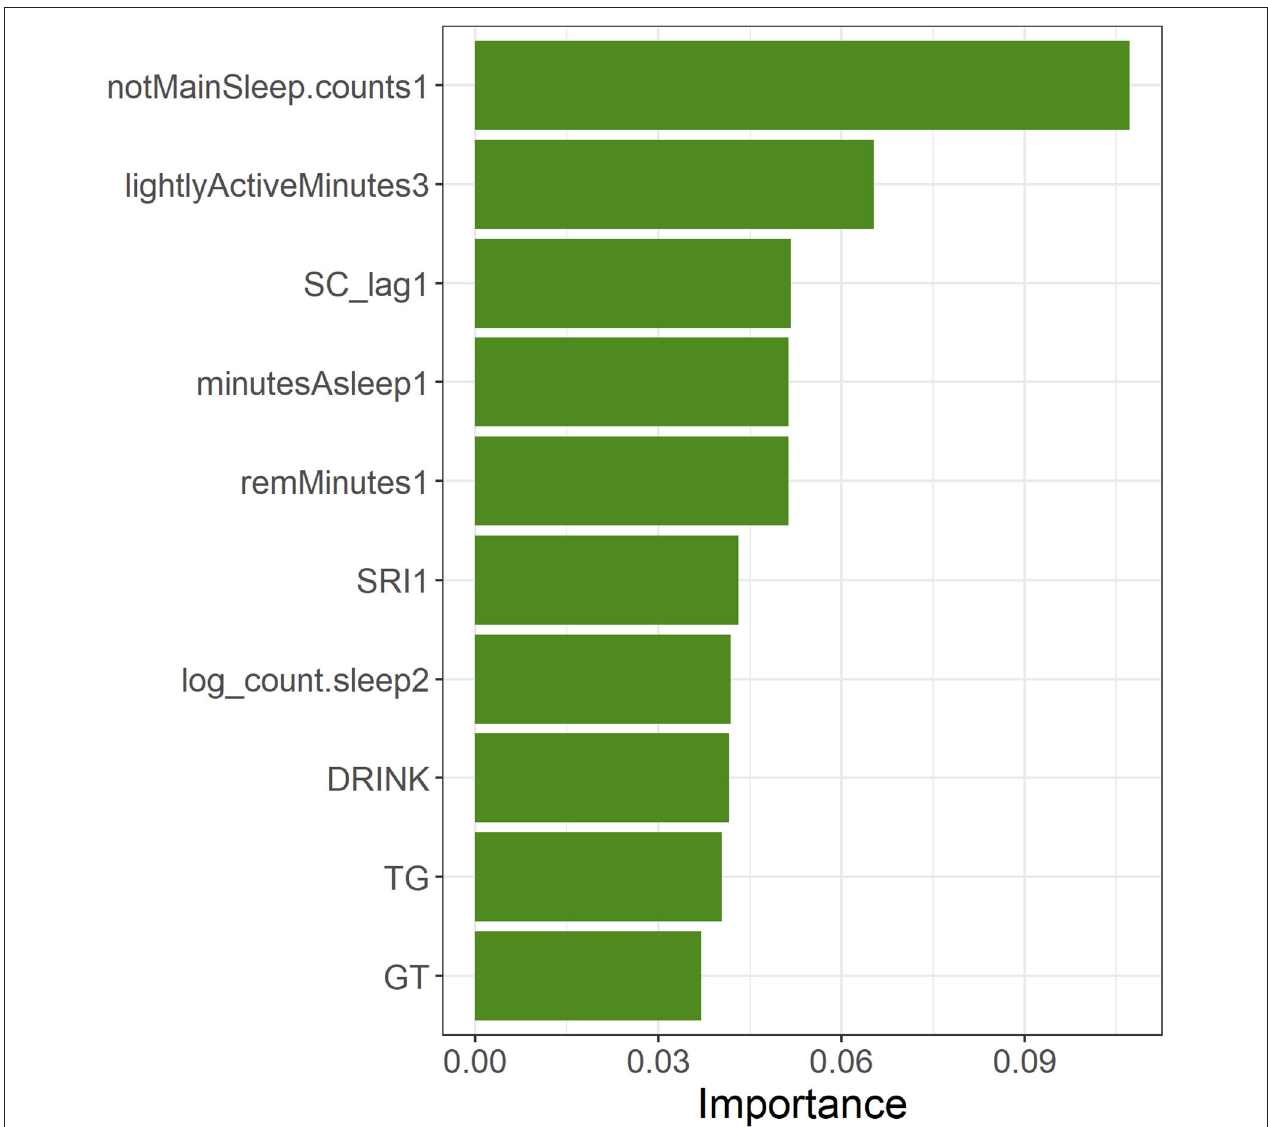
FIGURE 6 | Top-10 features in feature importance (gain) of the XGBoost model built using all of the training